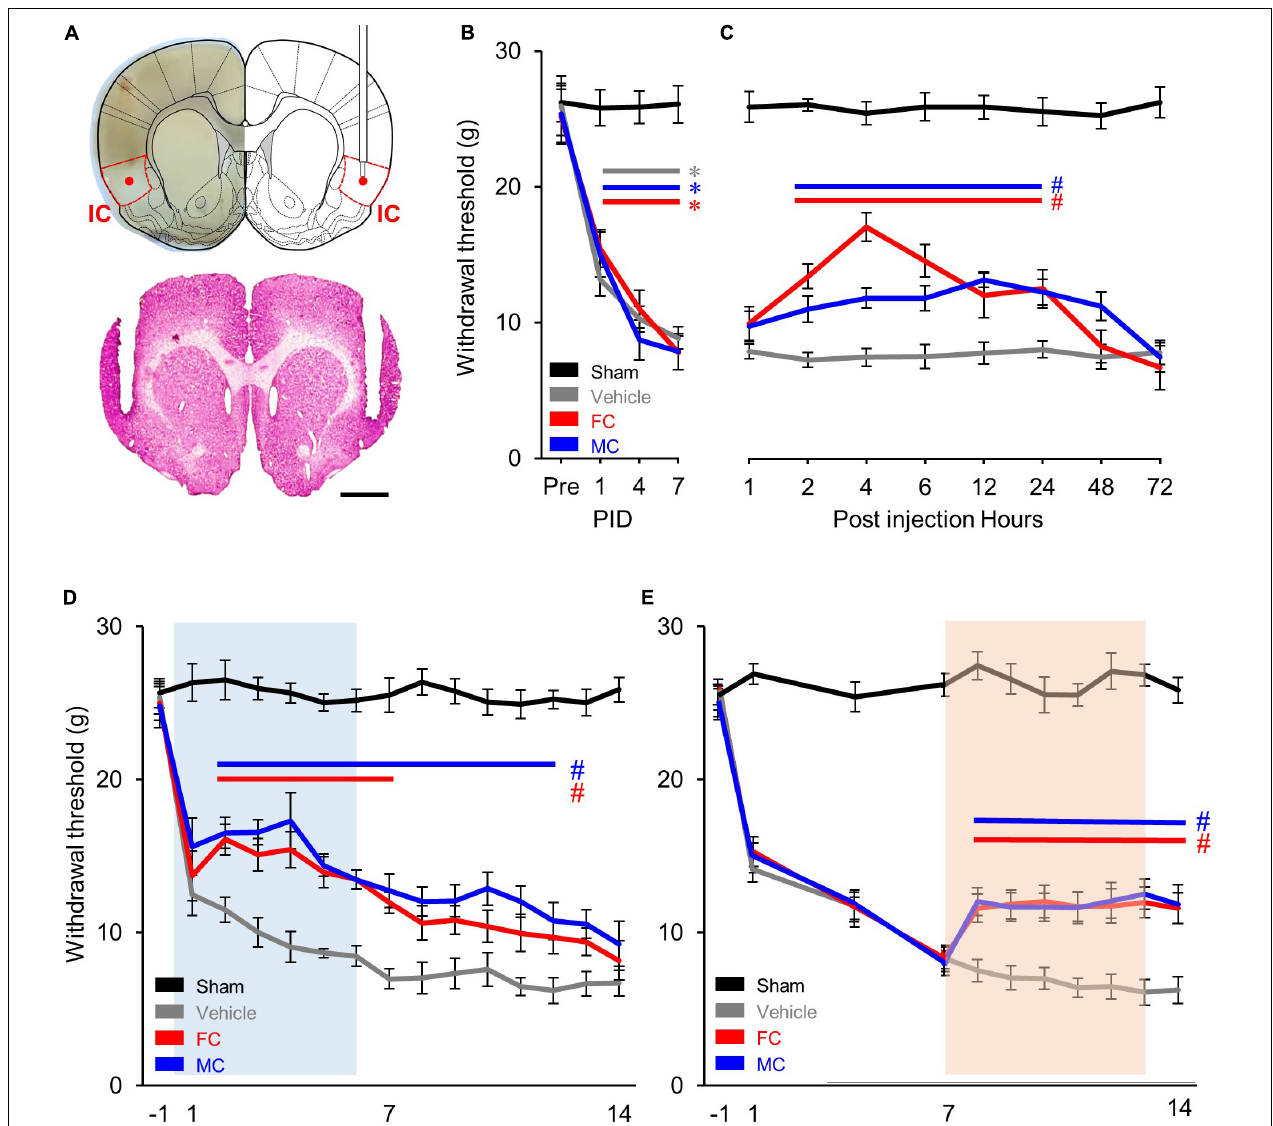
FIGURE 2 | Comparison of early and late inhibition of glial cells in chronic pain. (A) Location of the implanted cannulae for drug injection. Dotted red lines indicate the insular cortex (IC). The guide cannulae were bilaterally implanted into the target sites, and the injection cannulae were inserted through the guide cannulae to diffuse the drugs to the target areas (red dot). (B) Development of mechanical allodynia after nerve injury. The vehicle- ( n = 8) and fluorocitrate (FC)- ( n = 8) and minocycline (MC)- ( n = 8) treated groups that received nerve injury showed a significant decrease in mechanical withdrawal threshold on post-injury days (PIDs) 1, 4, and 7 compared to the sham group ( n = 8). (C) Pain attenuation effects of single injection of FC or MC on PID 7. After drug injection, the FC-treated group ( n = 8) showed significant pain alleviation effects for 2–24 h compared to the vehicle group ( n = 8). Pain alleviation effects on the MC-treated group ( n = 8) started 2 h after MC injection and was maintained for up to 24 h after injection compared to the vehicle group. (D) Changes in withdrawal threshold (WT) after early inhibition of astrocytes by FC or microglia by MC in the IC. After nerve injury, the WT of the vehicle group ( n = 12) was reduced from PID 1 to PID 14 compared to the sham group ( n = 12). The blue square on the background indicates the period of repetitive injection in early inhibition. The FC group ( n = 12) showed significant pain-relieving effects from PID 2 to PID 7. The MC group ( n = 12) showed significant analgesic effects from PID 2 to PID 12. (E) Changes in WT after late inhibition of astrocytes or microglia in the IC under chronic pain conditions. The orange square on the background indicates the period of repetitive injection in late inhibition. Both the FC ( n = 12) and MC ( n = 12) groups showed significant pain-relieving behaviors from PID 7 to PID 14 compared to the vehicle group ( n = 12). Error bars are SEM; ∗ p < 0.05 vs. Sham, # p < 0.05 vs. Vehicle; two-way ANOVA followed by Bonferroni’s post hoc multiple comparison test. Each colored horizontal line indicates statistical significance.